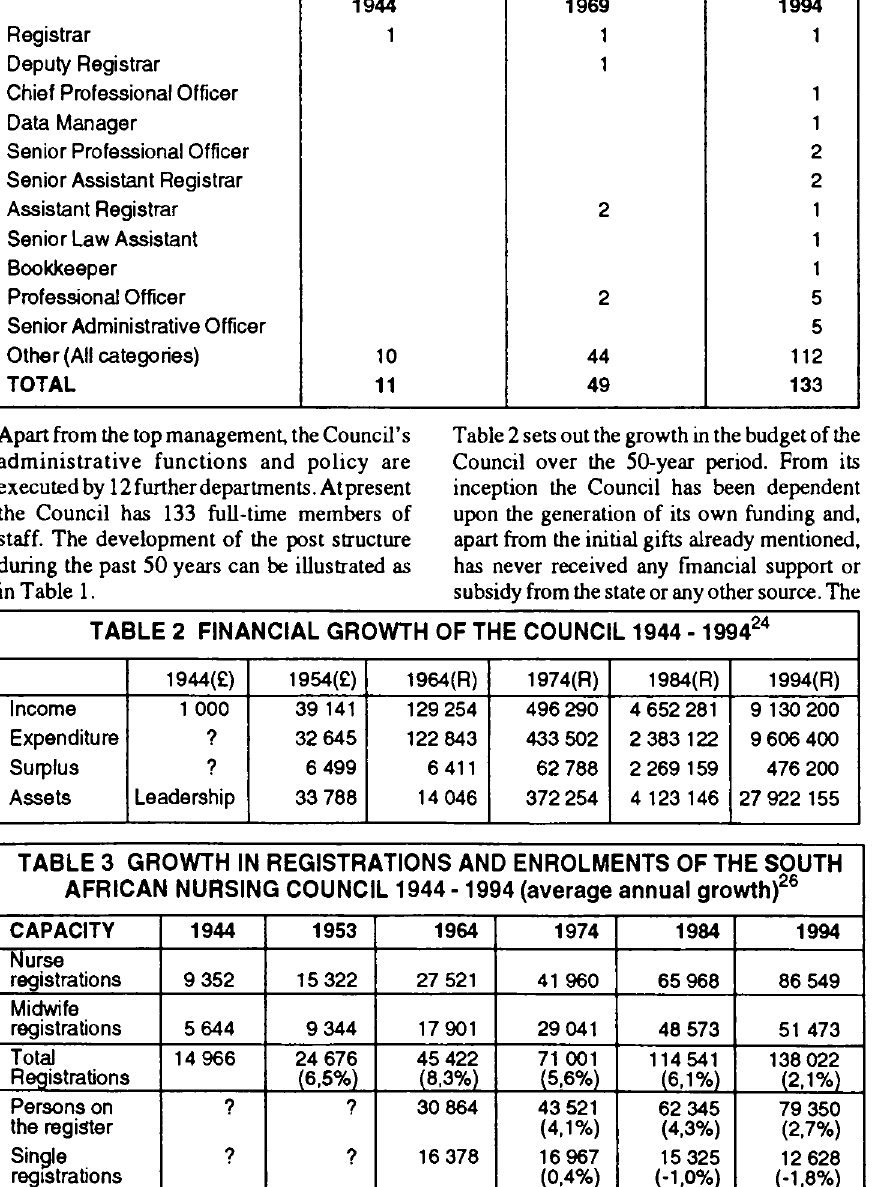
TABLE 4 RATIO OF POPULATION TO SELECTED HEALTH PRACTITIONERS'^^